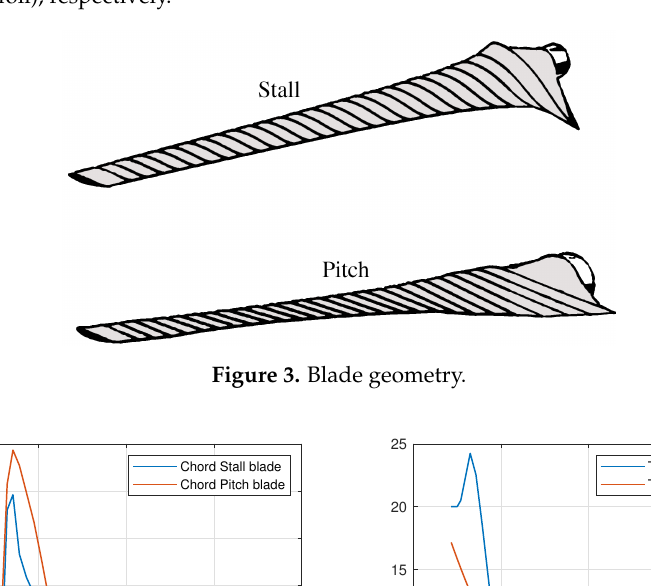
Figure 2. Representative airfoils for turbines using stall (DU-210_xx airfoils) and pitch regulation (NACA 4412 airfoil), respectively.